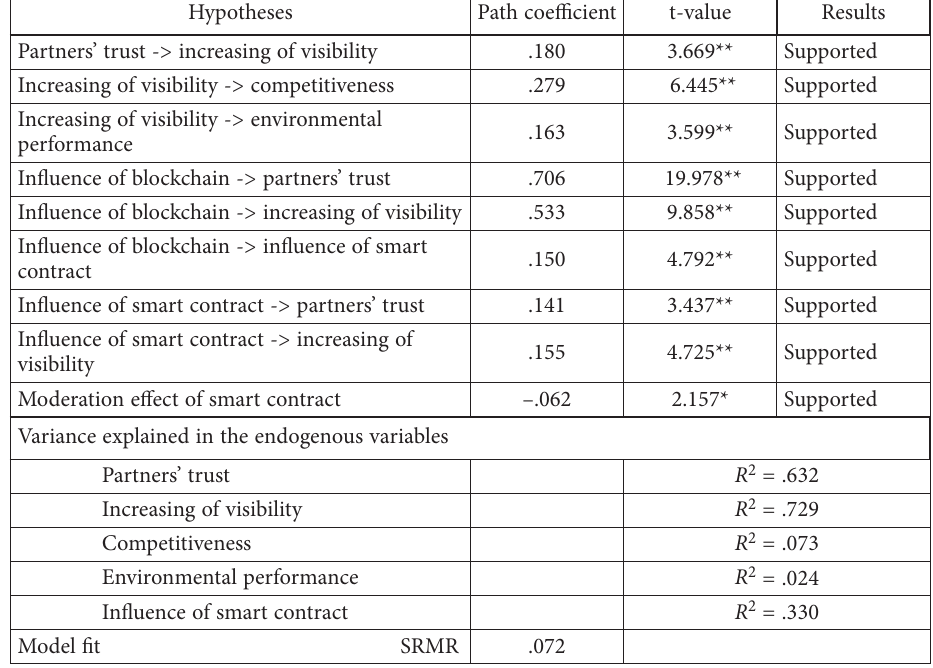
Table 4. PLS structural model